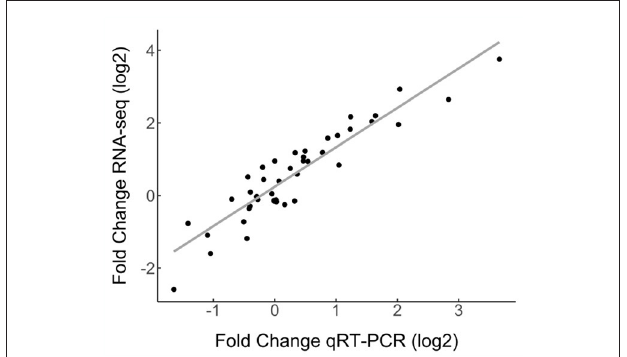
FIGURE 3 | Correlation of RNA-seq and qRT-PCR gene expression data. Ten differentially expressed genes and two reference genes from the RNA-seq dataset were evaluated by qRT-PCR. Gene expression by qRT-PCR was normalized to the CqAct2 reference gene. Fold change was measured by comparing samples treated with Trichoderma against mock- treated. The selected genes were assessed in all quinoa- Trichoderma combinations as averages of triple biological replicates. The Pearson correlation coefficient between the RNA-seq and qRT-PCR data was 0.921 (For data see Supplementary Table 5 ).